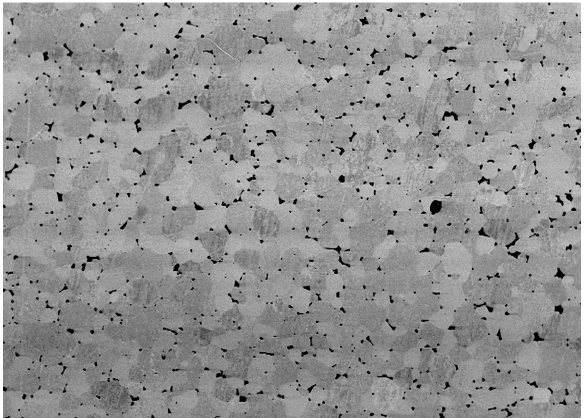
Figure 5. Microstructure image of the 77W-20Re-3Ni alloy (500× magnification).